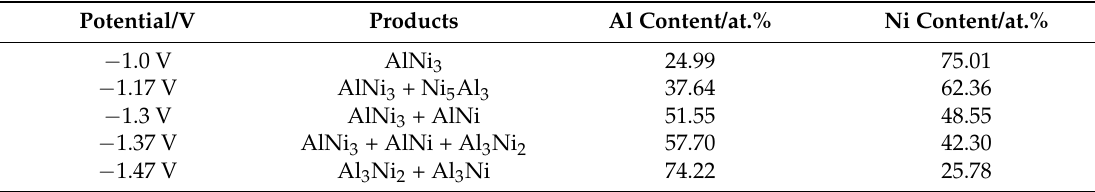
Figure 6. EDS of samples obtained by potentiostatic electrolysis on Ni plate at different potentials from LiCl-KCl-AlCl 3 (2 wt.%) melts at 753 K, ( a ) − 1.0 V (vs. Pt) for 9 h; ( b ) − 1.17 V (vs. Pt) for 12 h; ( c ) − 1.28 V (vs. Pt) for 12 h; ( d ) − 1.37 V (vs. Pt) for 12 h, and ( e ) − 1.47 V (vs. Pt) for 12 h. Table 1. Al and Ni contents of the Al-Ni alloys obtained at different deposition potentials as determined by EDS.